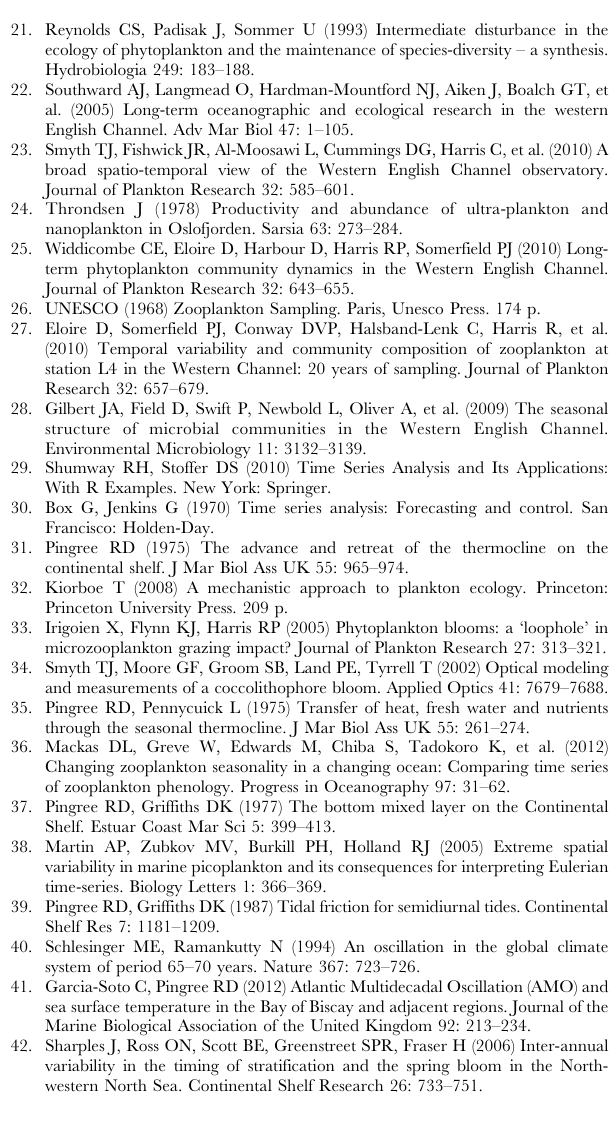
Figure S3 Length of growing season, calculated using the period of time between NHF positive and switching back to negative, as a function of NHF positive day. Calculations are for the period 1958–2011 at station E1. Fitted line has r= 2 0.73. (TIFF) Figure S4 Day of NHF negative (dashed line), between 1958 and 2011 at station E1, indicative of the end of the growing season. The solid line represents a spectral analysis of the calculated NHF time-series using a Box-Jenkins [30] approach. (TIFF) Table S1 Station L4 Phytoplankton and Microzooplank- ton Taxa List.